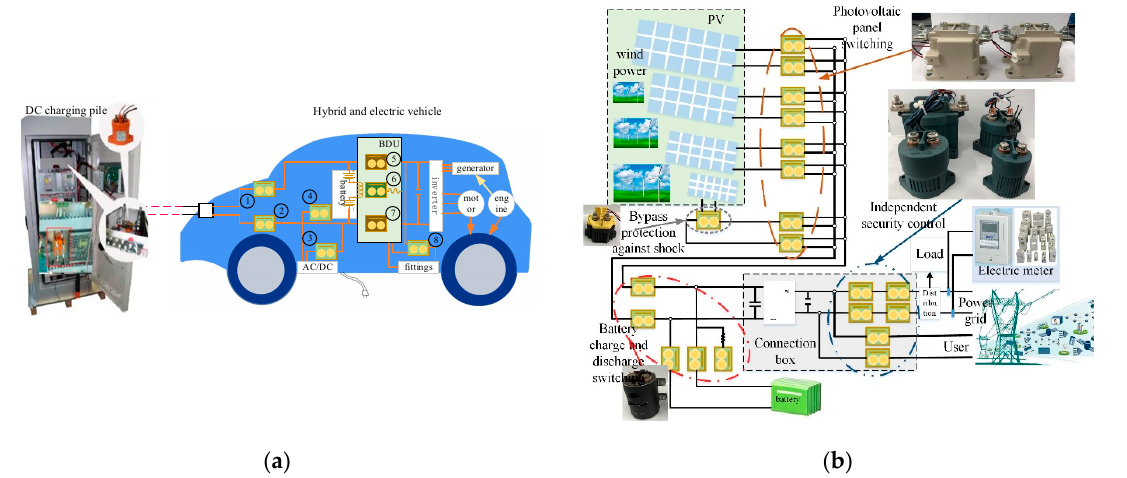
Figure 1. Application of high-voltage DC actuators: ( a ) application of high-voltage DC actuators in charging piles and electric vehicles; ( b ) application of high-voltage DC actuators in the field of new energy generation and electricity.